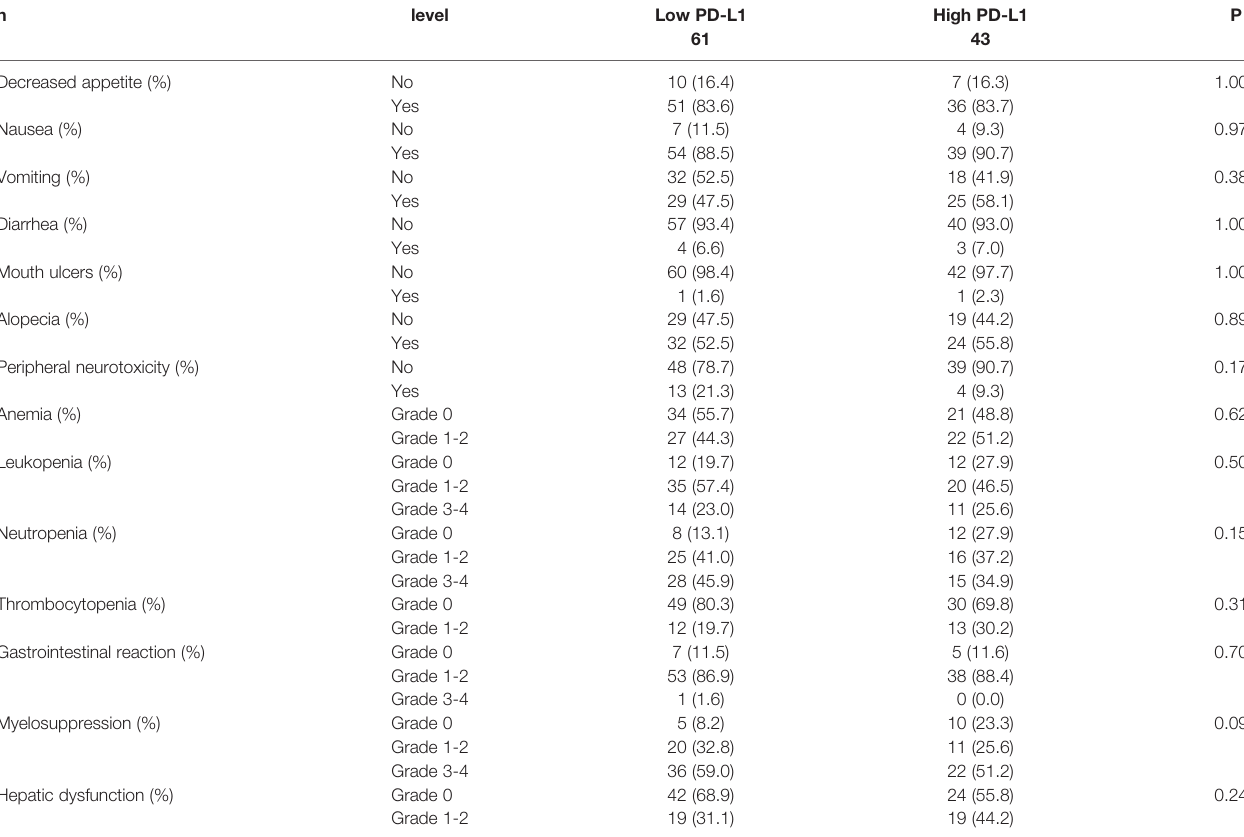
TABLE 4 | Patients ’ side effects of chemotherapy for all patients according to programmed cell death ligand-1 (PD-L1). n